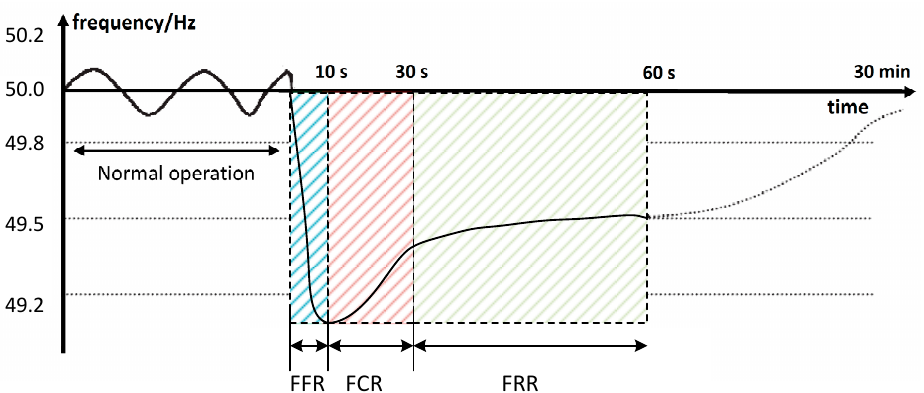
Figure 1. Frequency regulation processes and their activation times.